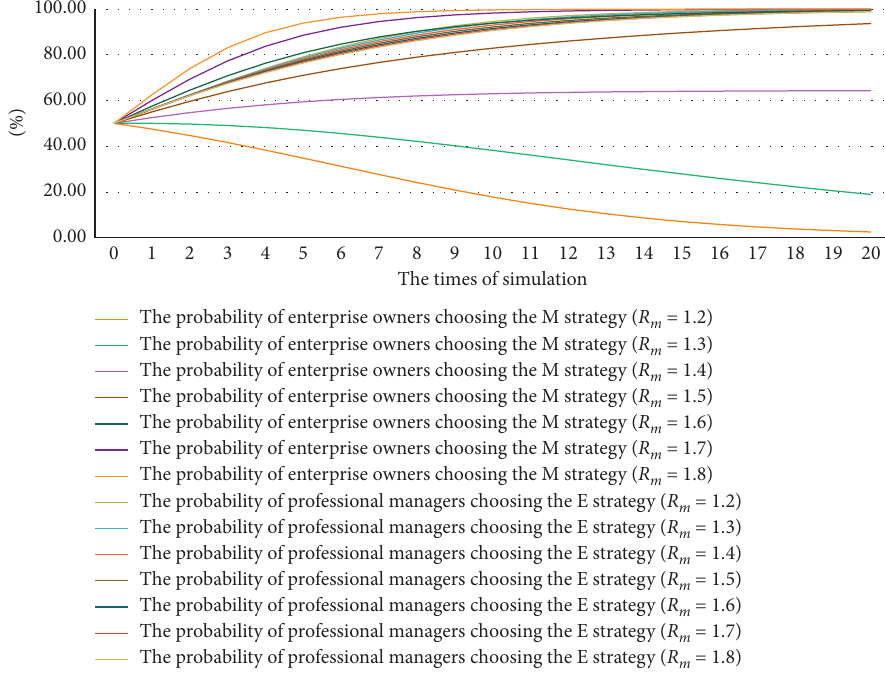
Figure 12: The impact of R m on the evolutionary results.